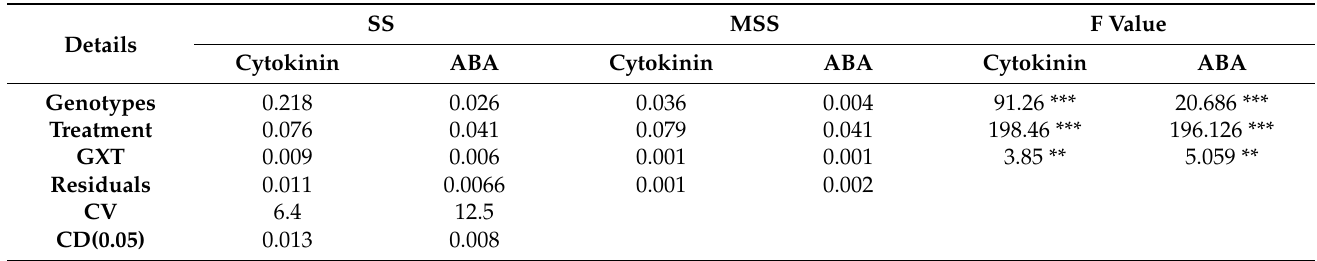
Table 4. Two-way ANOVA analysis for cytokinin and ABA modulation in the germinated